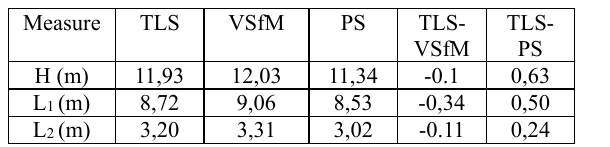
Table 4: Comparison between the measurements